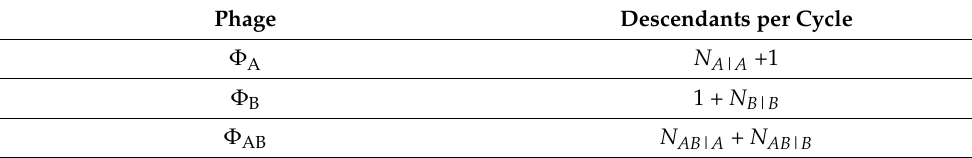
Table 3. Combined growth after pooling with Parallel